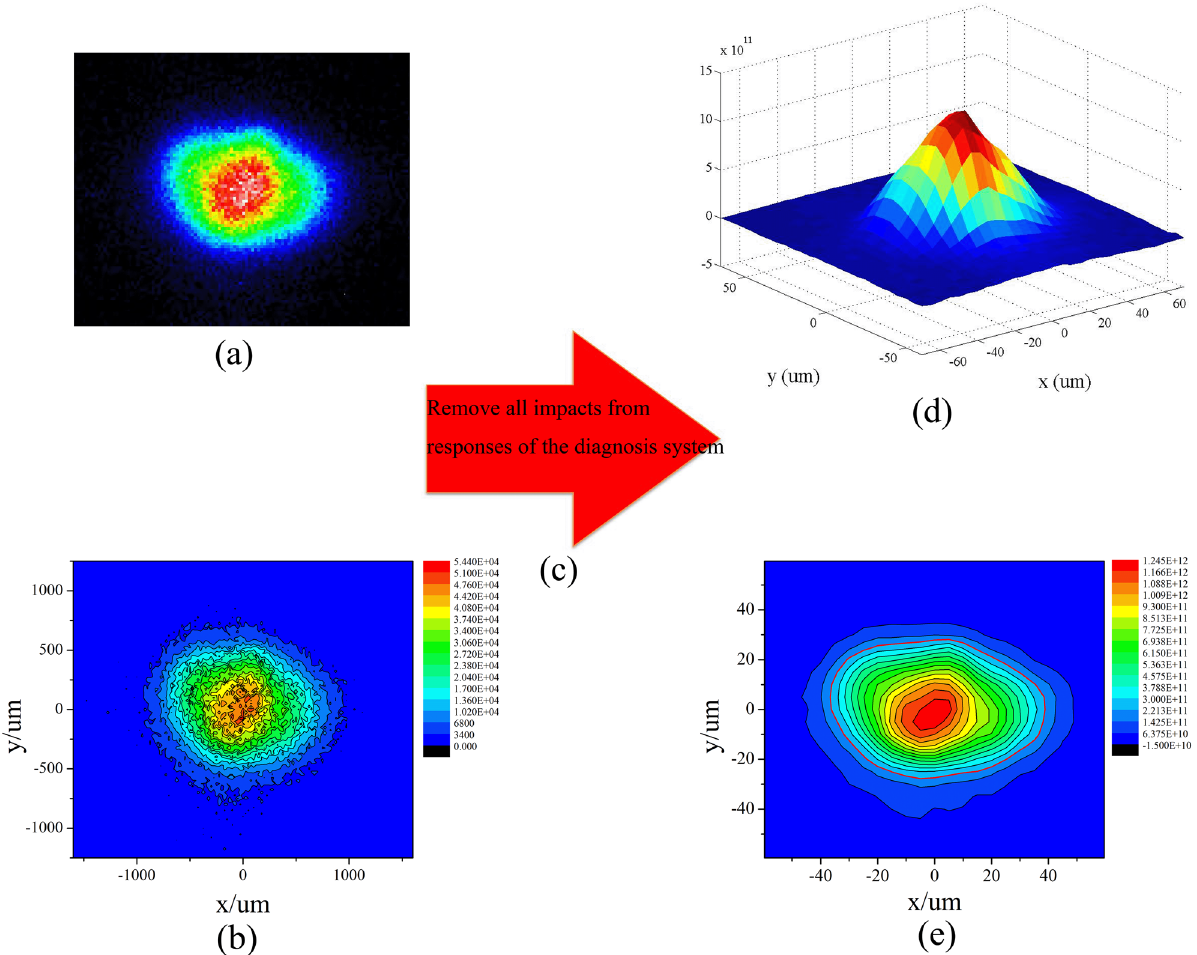
Figure 4. (Color online) ( a ) Observation results of imaging plate—the original image. ( b ) Original image coupled with the contour line. ( c ) Procedure of quantitative data process. ( d ) Photon number distribution images of quantitative and 5- µ m-space-resolving 8 keV self-emission of hotspot. ( e ) Photon number distribution images coupled with the contour line. The red line is the 17.81% contour.